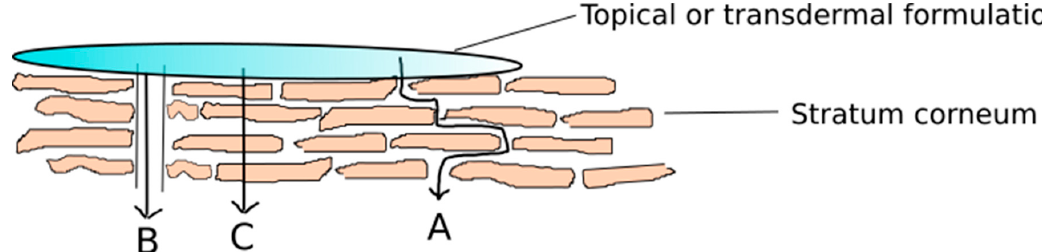
Figure 2. Routes of penetration. A: Intercellular penetration pathway, B: Follicular penetration pathway, C: Transcellular penetration pathway.